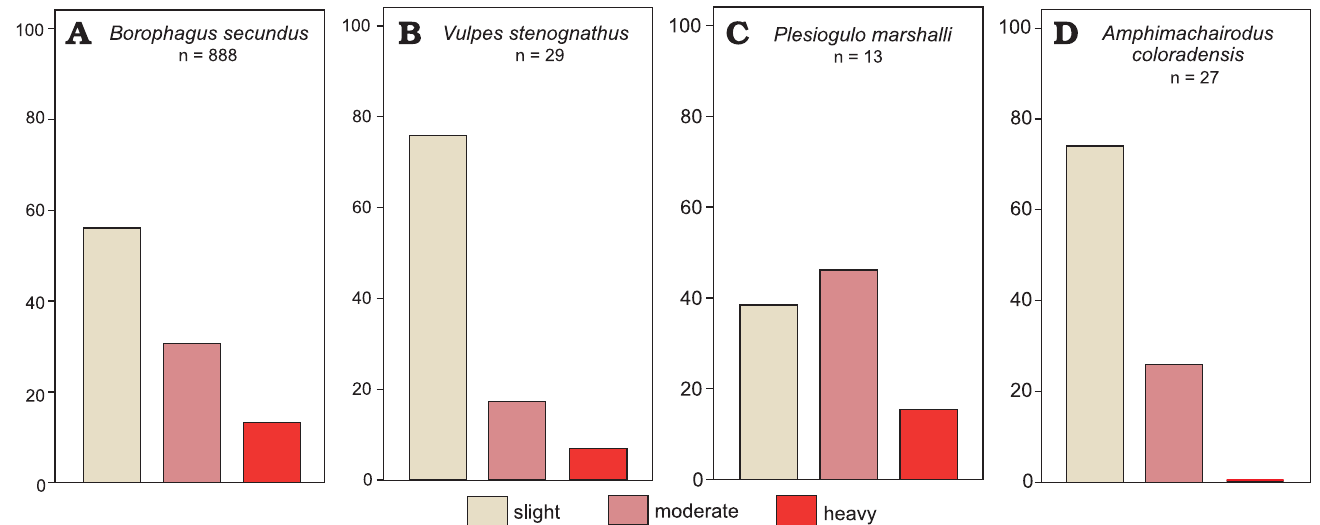
Fig. 7. Tooth wear frequencies for Optima Local Fauna (Miocene, late Hemphillian, Oklahoma, USA) carnivorans. Borophagus secundus ( A ), Vulpes stenognathus ( B ), Plesiogulo marshalli ( C ); Amphimachairodus coloradensis ( D